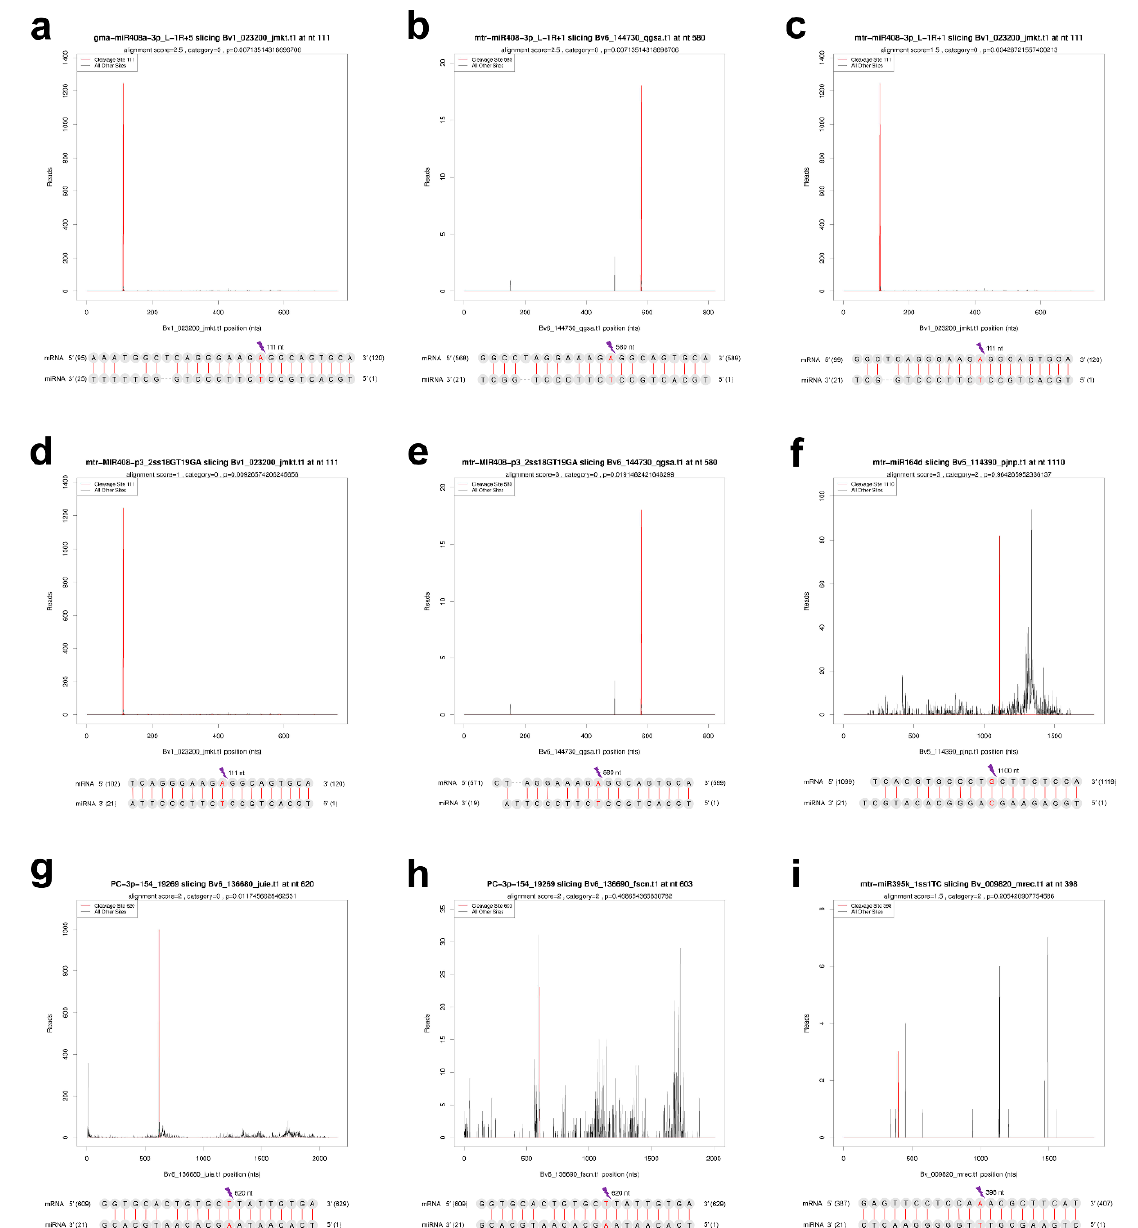
Figure 6. T-plots and alignments of miRNA–mRNA pairs validated by degradome sequencing. ( a ) bv1_023200_jmkt.t1 cleaved by gma-miR408a-3p_L-1R+5; ( b ) bv6_144730_qgsa.t1 cleaved by mtr-miR408-3p_L-1R+1; ( c ) bv1_023200_jmkt.t1 cleaved by mtr-miR408-3p_L-1R+1; ( d ) bv1_023200_jmkt.t1 cleaved by mtr-MIR408-p3_2ss18GT19GA; ( e ) bv6_144730_qgsa.t1 cleaved by mtr-MIR408-p3_2ss18GT19GA; ( f ) bv5_114390_pjnp.t1 cleaved by mtr-miR164d; ( g ) bv6_136680_juie.t1 cleaved by PC-3p-154_19269; ( h ) bv6_136690_fscn.t1 cleaved by PC-3p-154_19269; ( i ) bv_009820_mrec.t1 cleaved by mtr-miR395k_1ss1TC. The ‘lightning’ shape indicates the position of the cleavage site.